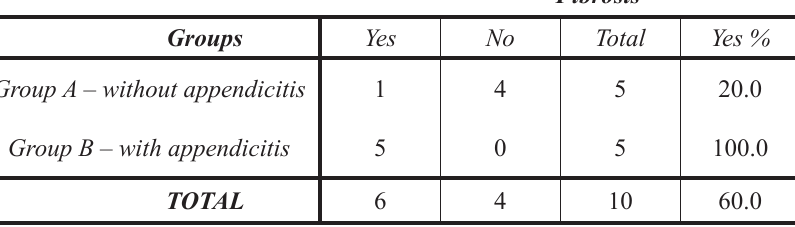
TABLE 7 - Rabbits from groups A and B in the three operative using LigaSure TM for